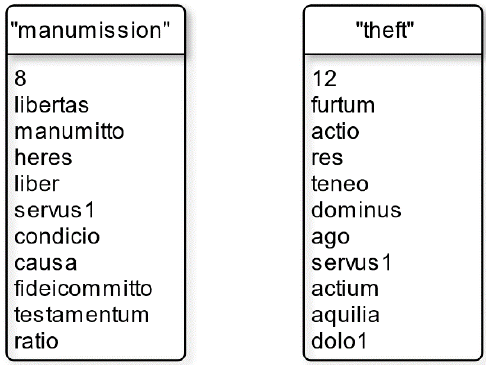
Figure 5. Two example clusters from the empirical conceptual tree-map of Roman law.